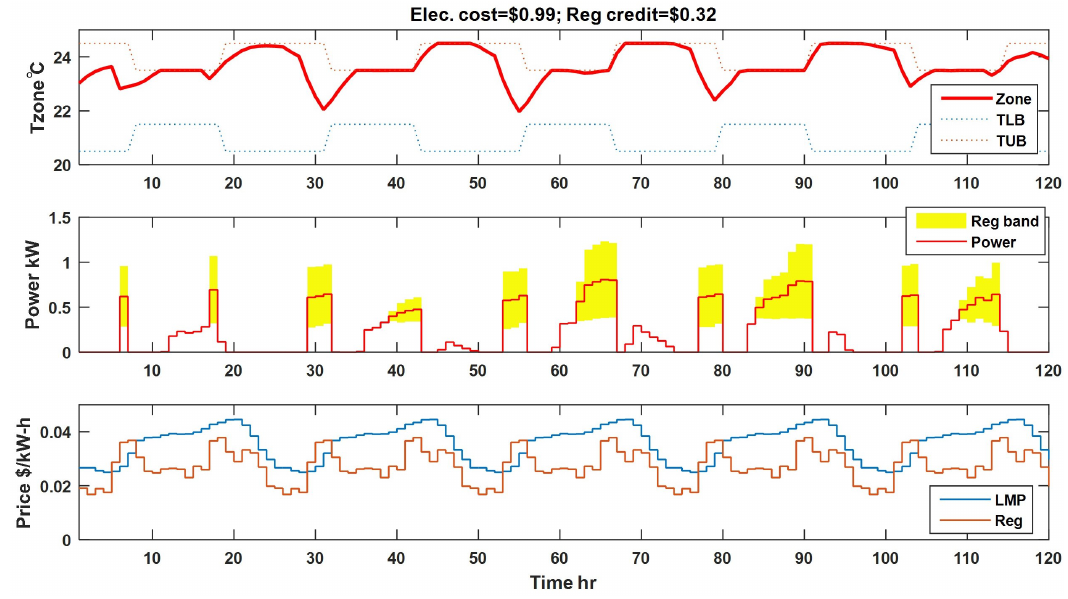
Figure 11. Optimal control results.